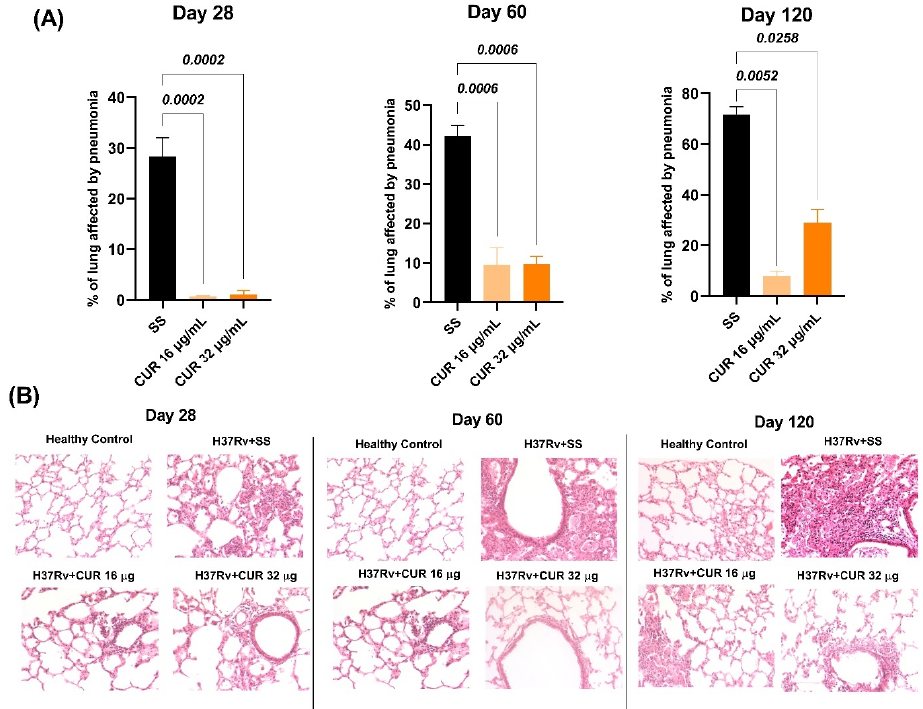
Figure 2. Effect of curcumin (CUR) treatment (16 μ g/mL or 32 μ g/mL) starting in the early TB infec- tion (14 days post-infection) on pneumonia of infected mice with 2.5 × 10 5 Mtb colony-forming units (CFU) virulent strain H37Rv. ( A ) Percentage of the pneumonic area determined by automated mor- phometry at 28, 60 and 120-days post-infection of control mice that only received saline solution (SS) as the vehicle, and infected animals treated with CUR. Day 28 F (2, 6) = 52.30, p = 0.0002, ordinary ANOVA. Dunnett’s multiple comparisons test. Day 60 F (2, 6) = 36.98, p = 0.0004, ordinary ANOVA. Dunnett’s multiple comparisons test. Day 120 F (1.377, 2.753) = 65.86, p = 0.005, ordinary ANOVA.